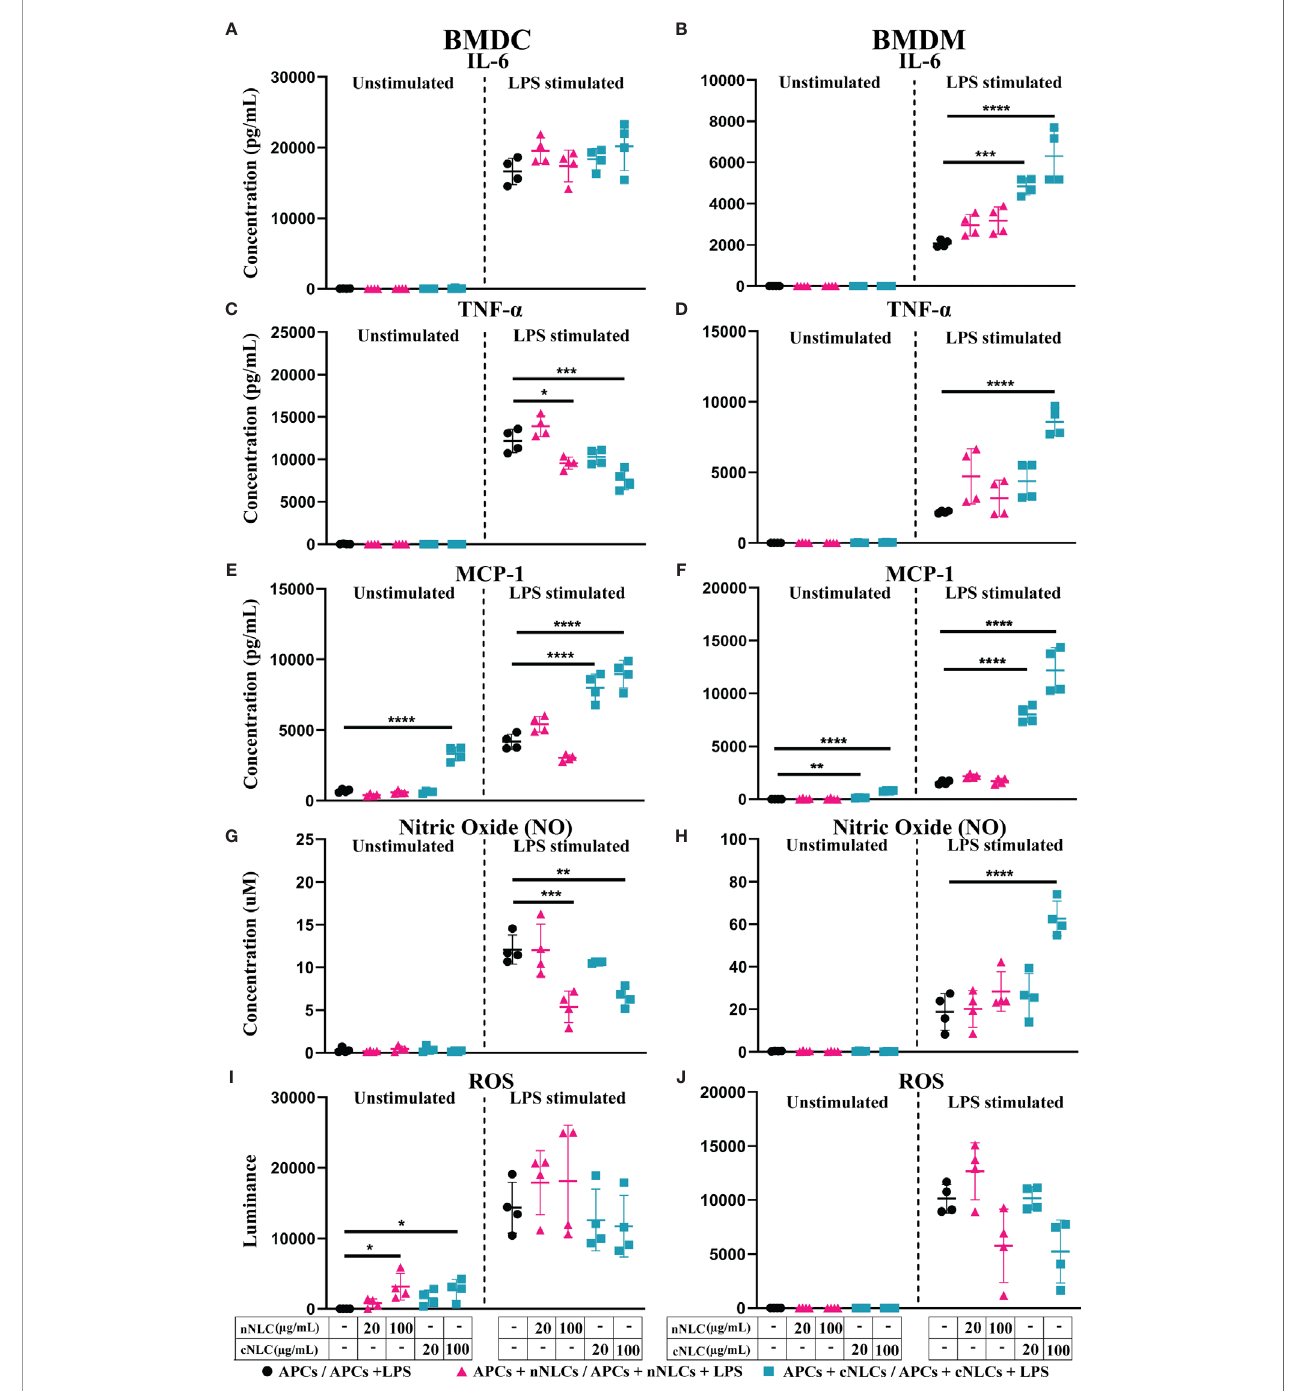
FIGURE 4 | Secretions of signalling factors by APCs in response to nNLCs or cNLCs. Relative cytokine and chemokine concentration in the supernatant of BMDCs and BMDMs exposed to nNLCs or cNLCs and activated or not by LPS was determined by immunoassay. Secretion of the IL-6 cytokine in (A) BMDCs and (B) BMDMs; the TNF a cytokine in (C) BMDCs and (D) BMDMs and the chemokine MCP-1 in (E) BMDCs and (F) BMDMs. Relative NO concentration in the supernatant of BMDCs (G) and BMDMs (H) cells exposed to nNLCs or cNLCs and activated or not by LPS was determined by Griess assay. ROS production by BMDCs (I) and BMDMs (J) cells exposed to nNLCs or cNLCs and activated or not by LPS was determined by ROS-Glo ™ H 2 O 2 assay. Data are displayed as mean ± SD (N = 4 independent experiments), and the statistical signi fi cance between nanocarrier treated or untreated groups was performed by one-way ANOVA test using Tukey ’ s multiple comparisons test. *P ≤ 0.05; **P ≤ 0.01; ***P ≤ 0.001; and ****P ≤